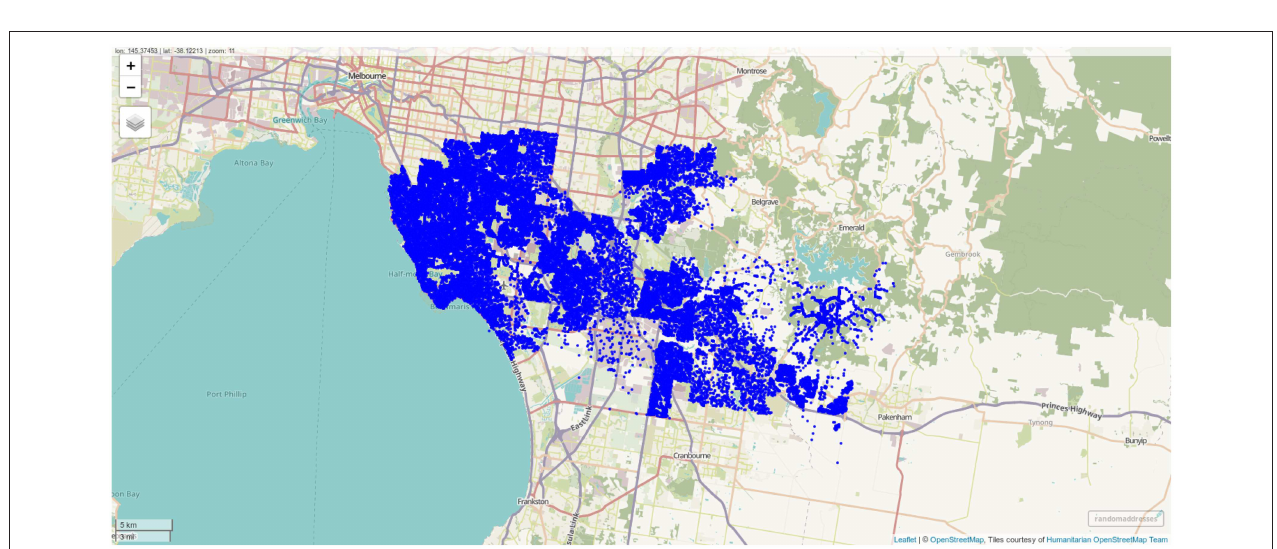
FIGURE 4 | Randomly sampled addresses within the postcodes of interest. One thousand addresses per postcode were sampled, and the differing population density across the postcodes of interest is clearly visible. Screenshot of interactive visualization created with mapview .